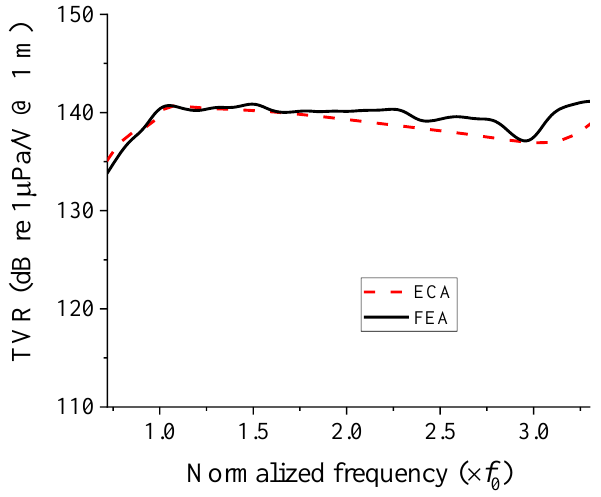
Figure 14. Comparison of the TVR spectra from the FEA and ECA.